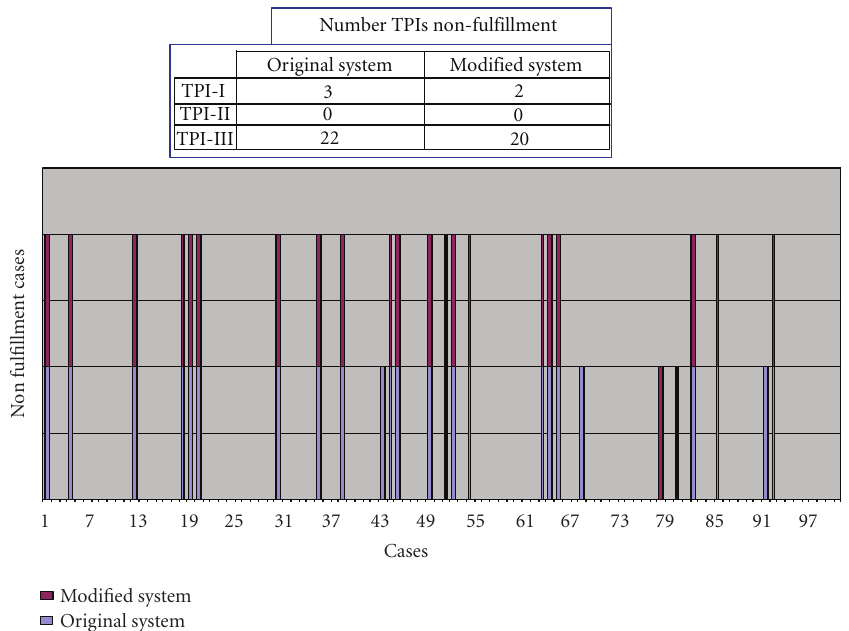
Figure 16: Transient performance indicators results comparison between original and modified system.